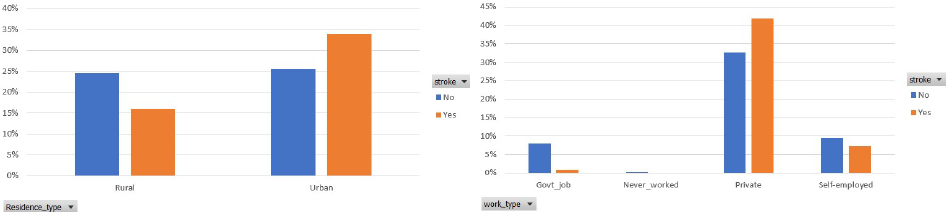
Figure 4. Participants distribution per residence and work type in the balanced